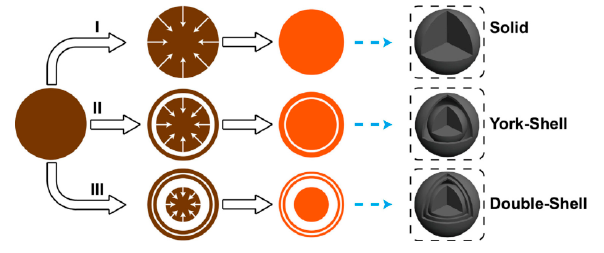
Figure 13. Formation process of ZnFe 2 O 4 double-shell, York-shell and solid microspheres. I heating rate: 1 °C/min; II heating rate:20 °C/min; III directly placed in 350 °C [59].